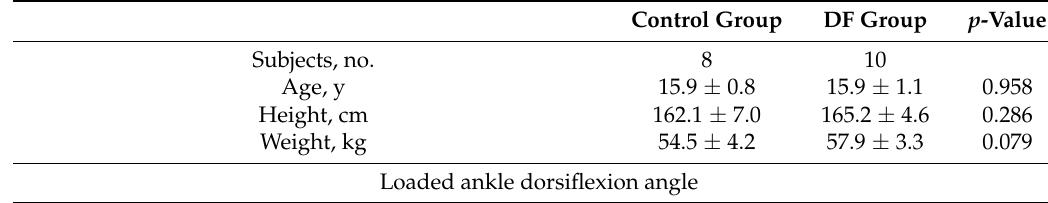
Table 1. Characteristics of